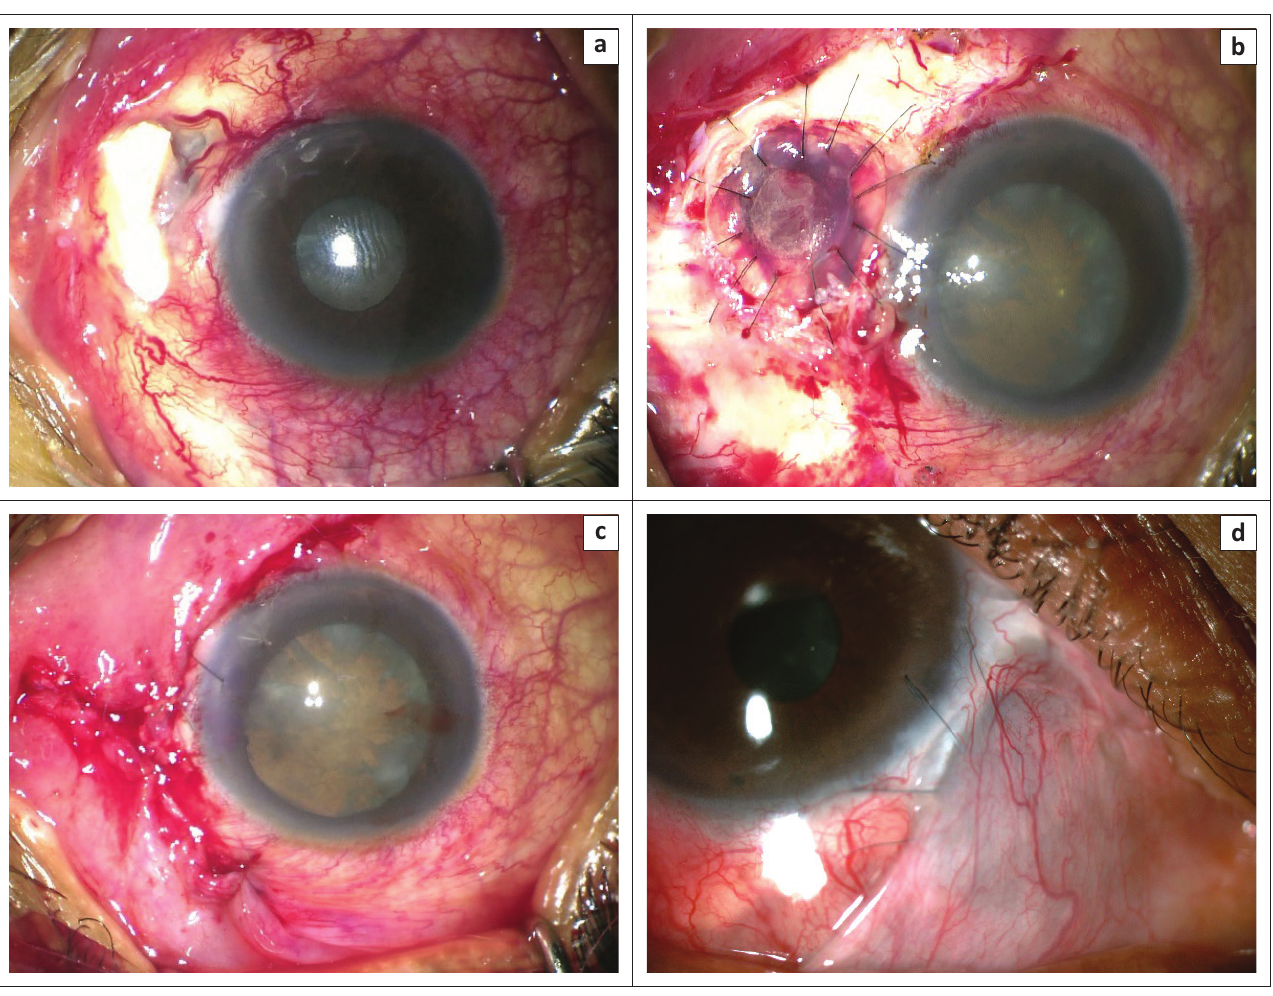
FIGURE 1: Anterior segment photos of the right eye. (a) Infectious scleritis resolved after a week of topical ciprofloxacin 0.3 % . Residual scleritis with calcific plaque at the time of surgery. (b) At surgery after removal of the calcific plaque and completion of the corneal patch. (c) At surgery after the patch has been closed with a vascular tenons and conjunctiva. (d) At last follow-up, 6 months after